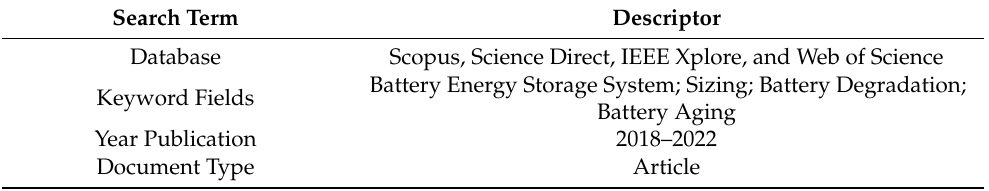
Table 1. Search term selection.